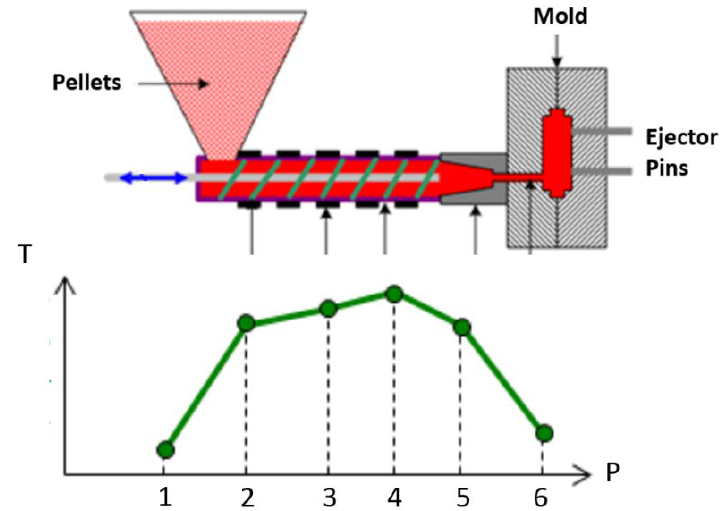
Figure 3. The temperature mapping corresponds to the plastic injection